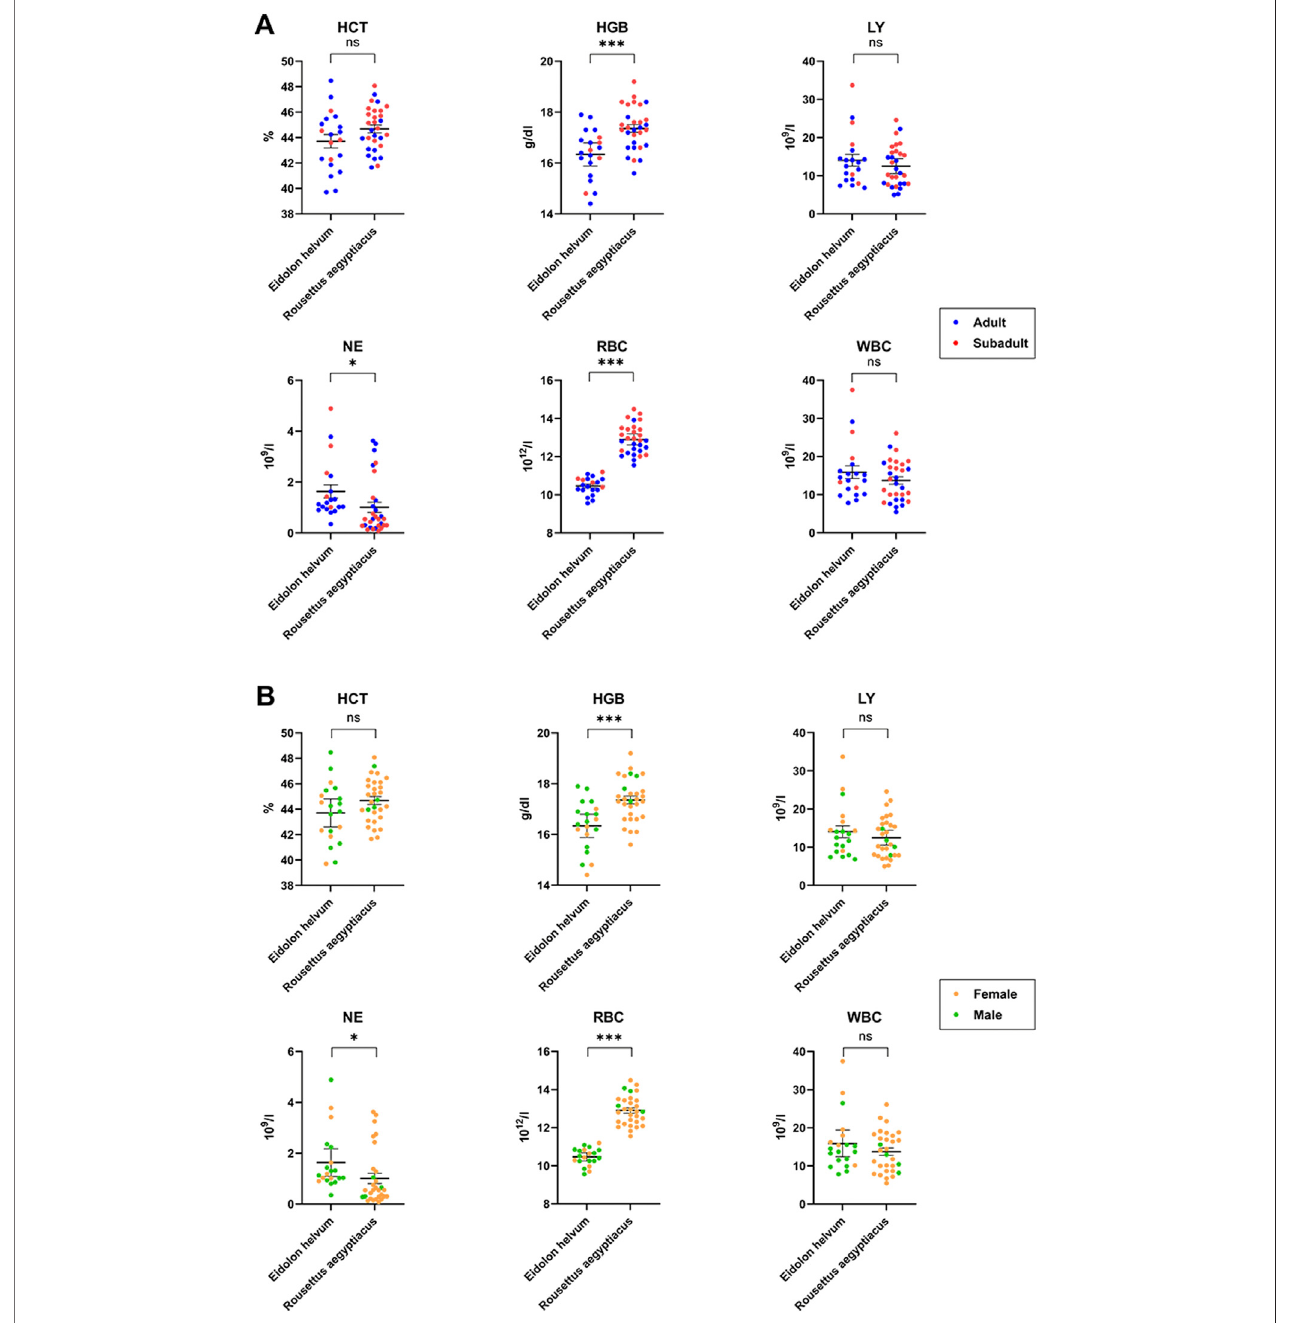
FIGURE 5 | Age- and sex-dependent variations of hematology in R. aegyptiacus and E. helvum . Single dots represent one animal (adult/subadult) (A) and female/ male (B) .Thesamecohortwasusedforcomparison.Dottedlinesrepresentthelowerdetectionlimit.Solidhorizontalbarsrepresentmean±SEM.Statisticallysigni fi cant differences were determined for hematology parameters (HGB, NE, RBC, HCT, LY, WBC), * = signi fi cant: p -value < 0.05; *** = extremely or highly signi fi cant: p -value < 0.001, ns = not statistically signi fi cant.